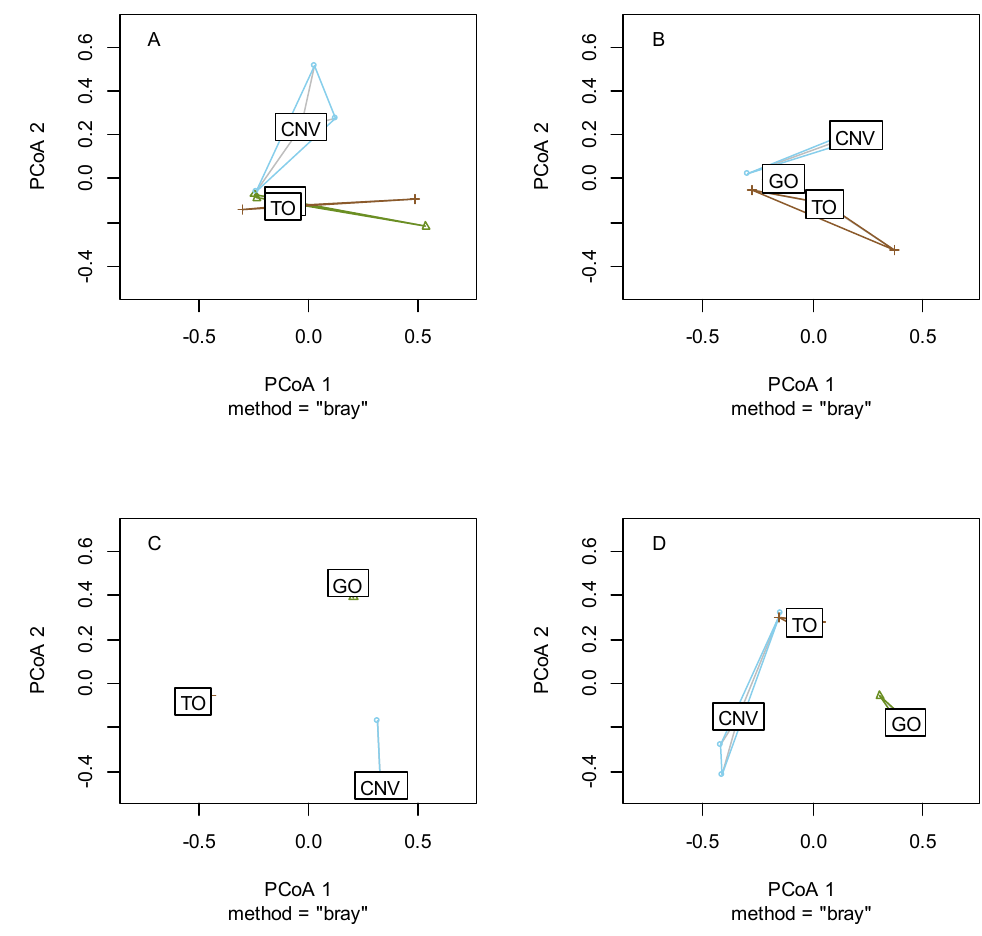
Figure 4. Principal coordinates analysis of weed biomass data in for conventionally managed (CNV), grazed organic (GO), and tilled organic (TO) plots within the safflower undersown with sweet clover (( A ), year = 2013), sweet clover (( B ), year = 2014), winter wheat (( C ), year = 2015) and lentil (( D ), year = 2016) rotation at Bozeman, MT, USA. The closer the points are together, the more similar the plant communities. Polygons that do not overlap are considered distinct weed communities. Table 2. Top 10 weed species (by percent of total biomass) in conventionally ‐ managed, grazed organic, and tilled organic plots within the safflower undersown with sweet clover (2013), sweet clover (2014), winter wheat (2015), and lentil (2016) rotation at Bozeman, MT, USA.